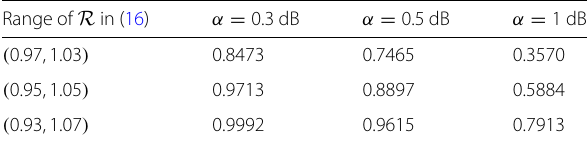
Table 1 Probability of the ratio R falls in a range